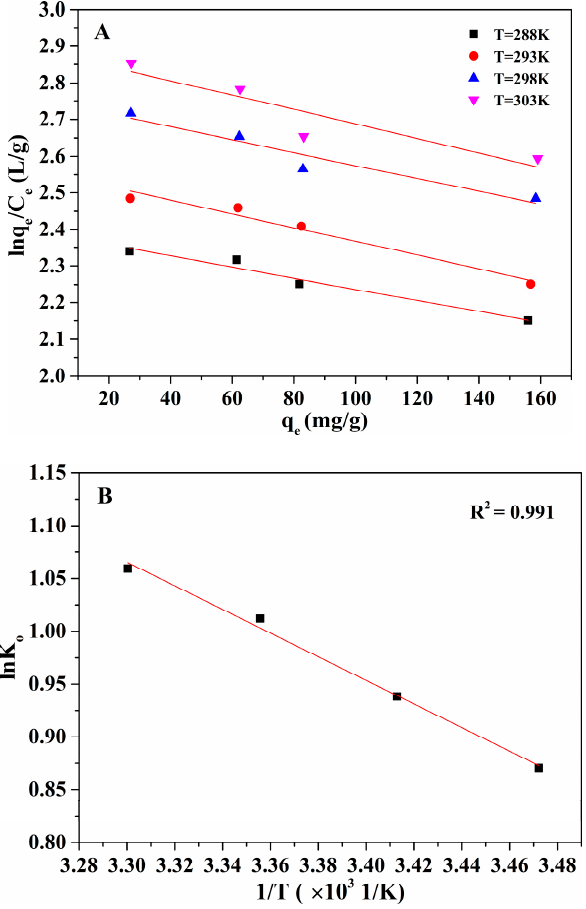
Figure 8. ( A ) Plots of lnq e /C e versus q e at different temperatures; ( B ) plot of lnK o versus 1/T. Table 2. Thermodynamic parameters for Cd 2+ sorption onto Alg-EDTA.